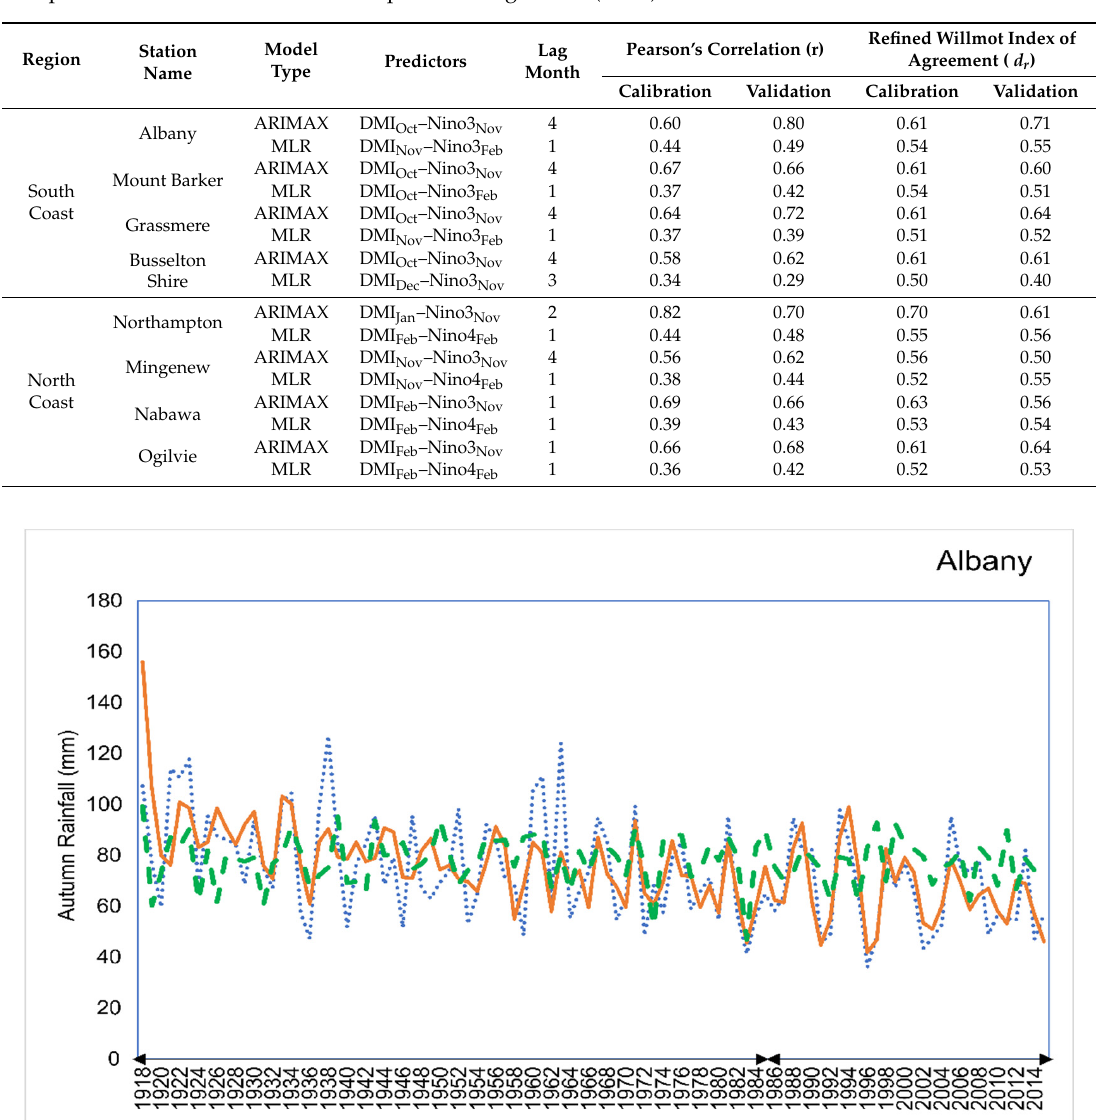
Table 7. Pearson correlation (r) and refined index of agreement ( d r ) in the calibration and validation period for the ARIMAX and multiple linear regression (MLR) model